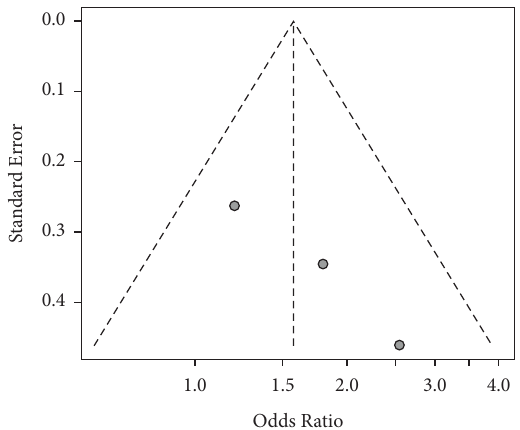
Figure 6: Funnel plots of the 3 RCT studies.